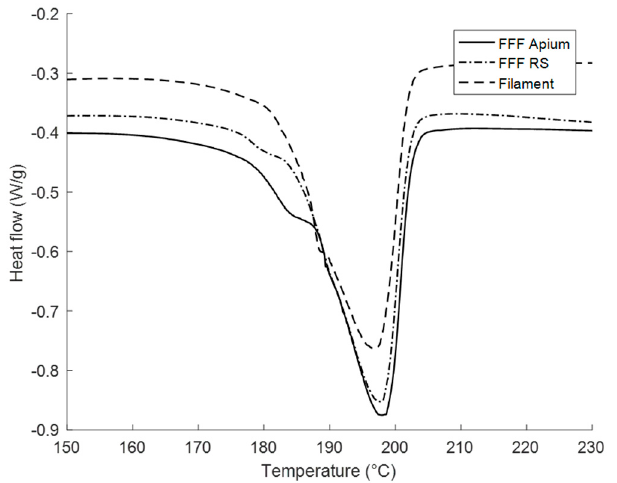
Figure 4. DSC thermograms for the first heating cycle of Nylon-12 filament, fused filament fabrication (FFF) Apium and FFF RS samples.